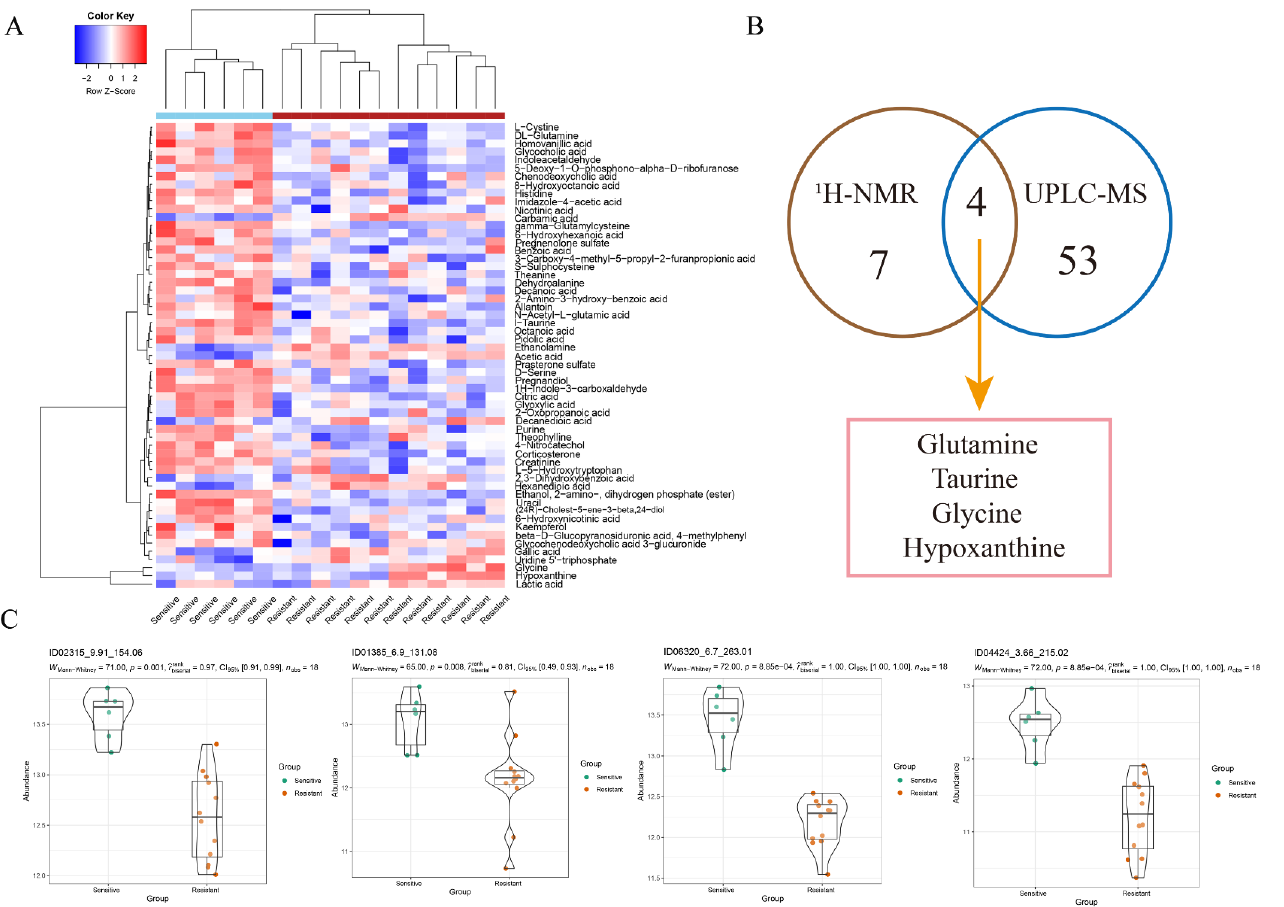
Figure 3. OPLS-DA analysis of the data obtained from UPLC-MS between the two groups. ( A ) Dif- ferential metabolites identified by UPLC-MS. Colours from blue to red indicate the relative intensity of the metabolites in the two groups. ( B ) Venn diagram shows the metabolites detected by both methods. ( C ) Other significant metabolites identified by UPLC-MS between the two groups.